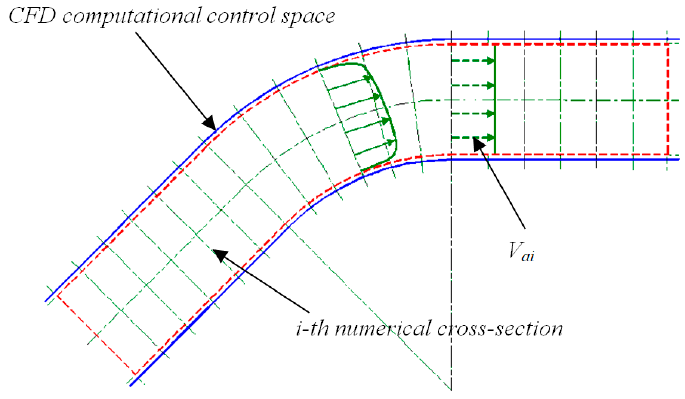
Figure A1. A pipe elbow with marked computational space.